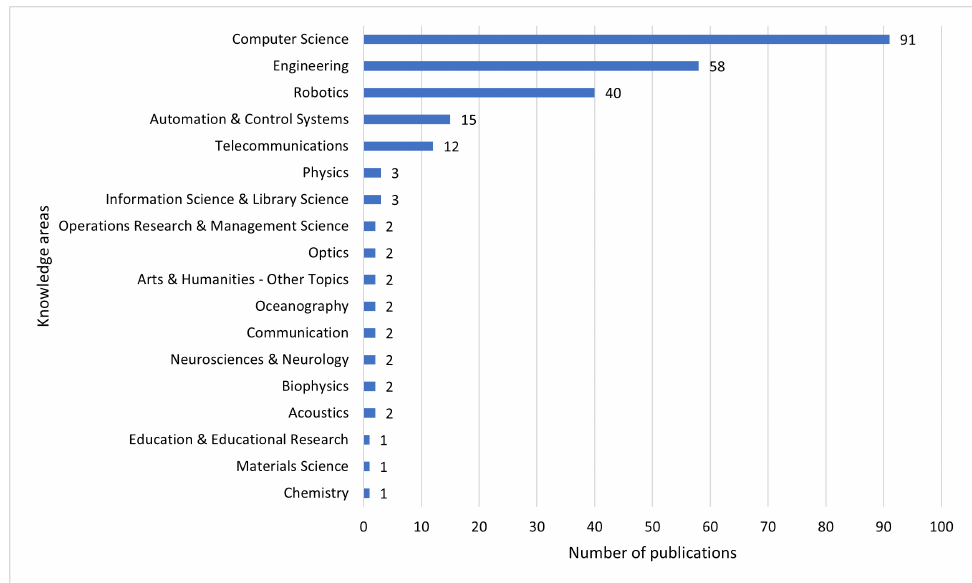
Figure 4. Web of Science research areas assigned to the 133 publications.